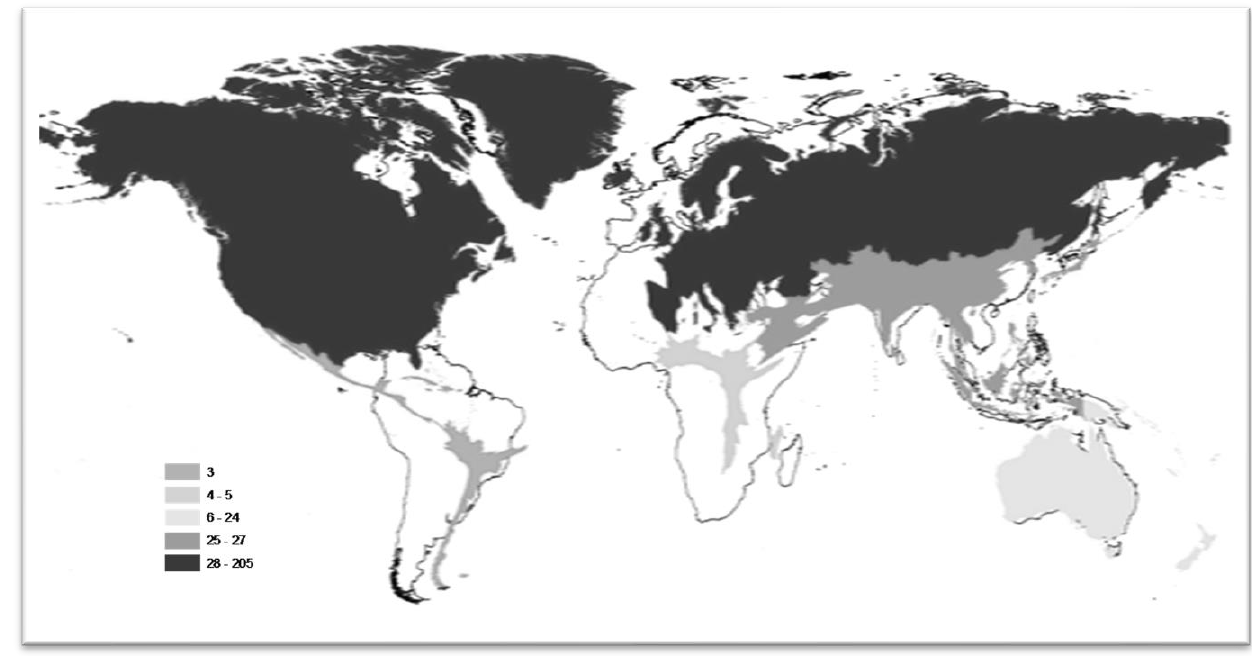
Figure 1: Resized world map according to the knowledge-production concentration of Crimes of the powerful research articles based on the authors’ affiliation (WoS Core C ollection